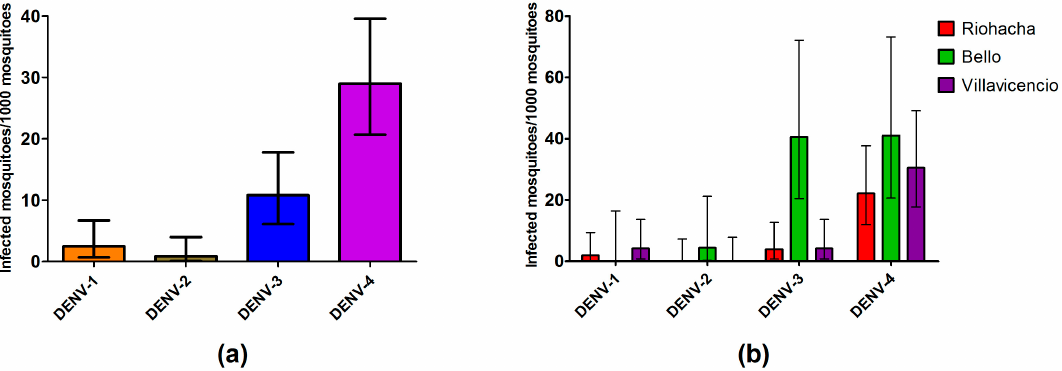
Figure 4. IR estimated with upper and lower limit (error bars) from mosquitoes for: each serotype ( a ); and serotypes discriminating by city ( b ).